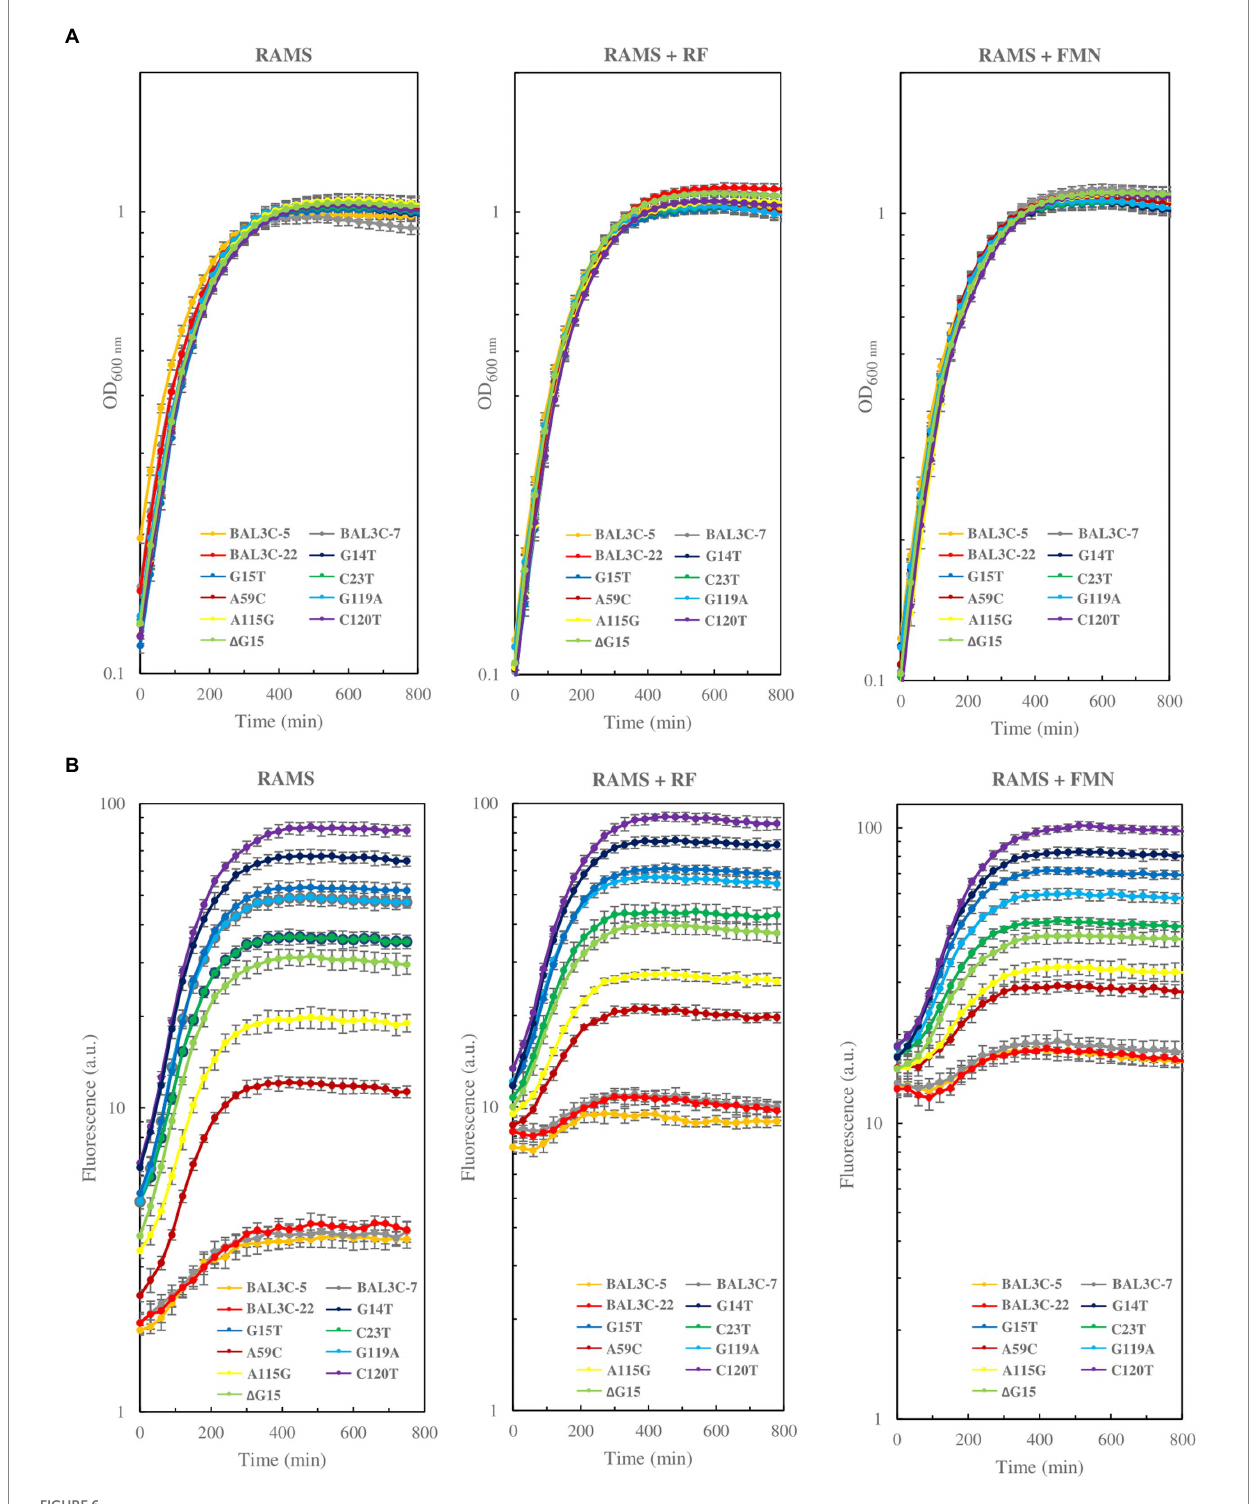
FIGURE 6 Comparative analysis of growth (A) and RF fluorescence (B) of the Weissella cibaria parental and mutant strains grown in RAMS, RAMS + FMN, and RAMS +